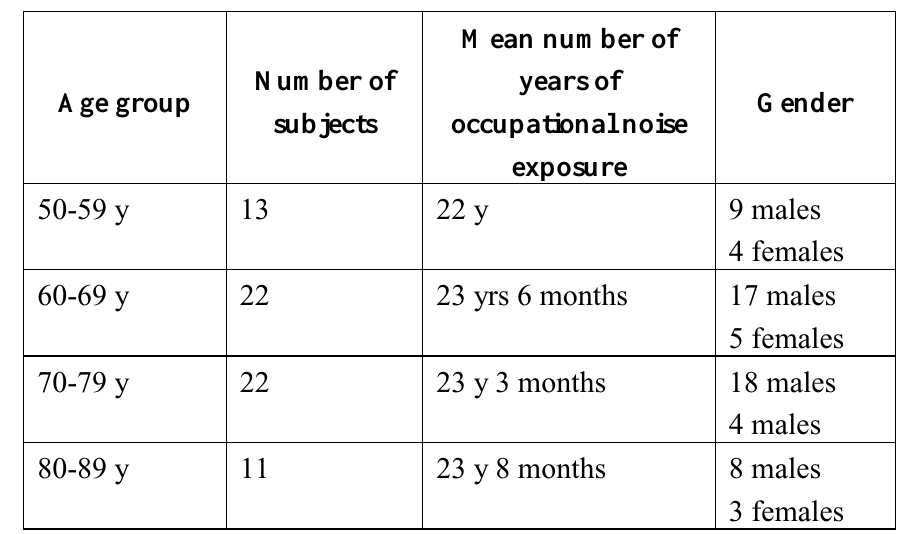
Table 1. Subject